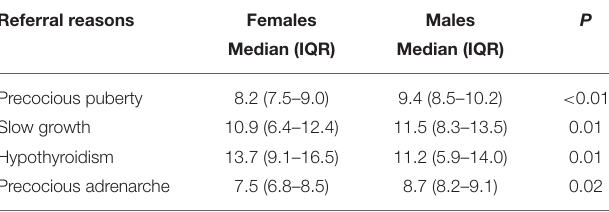
TABLE 3 | Statistically significant differences in age at referral between